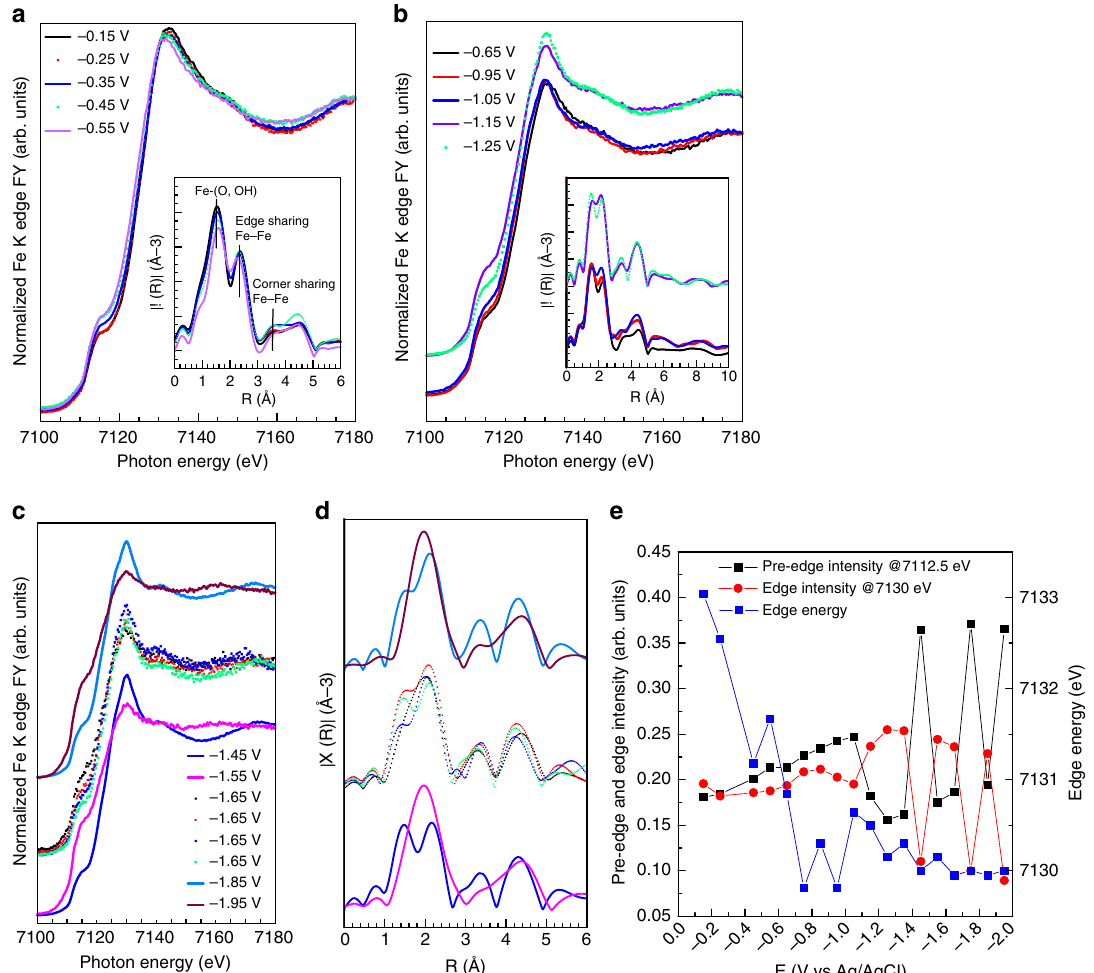
Fig. 8 FY-mode Fe K edge XANES spectra measured in quick mode in 0.05 M KHCO 3 at different potential and corresponding EXAFS spectra (inset) for the Fe/N-C. a CO 2 RR selective region and b HER selective region. c XANES spectra measured at high HER rate and d corresponding EXAFS spectra. Each spectrum is merged from 11 fast Fe K edge XANES spectra. The potential was varied in steps of 0.1 V and hold at constant potential for 3 minutes. e Pre- edge intensity at 7112.5 eV, edge intensity at 7130 eV, and edge energy plotted as function of the